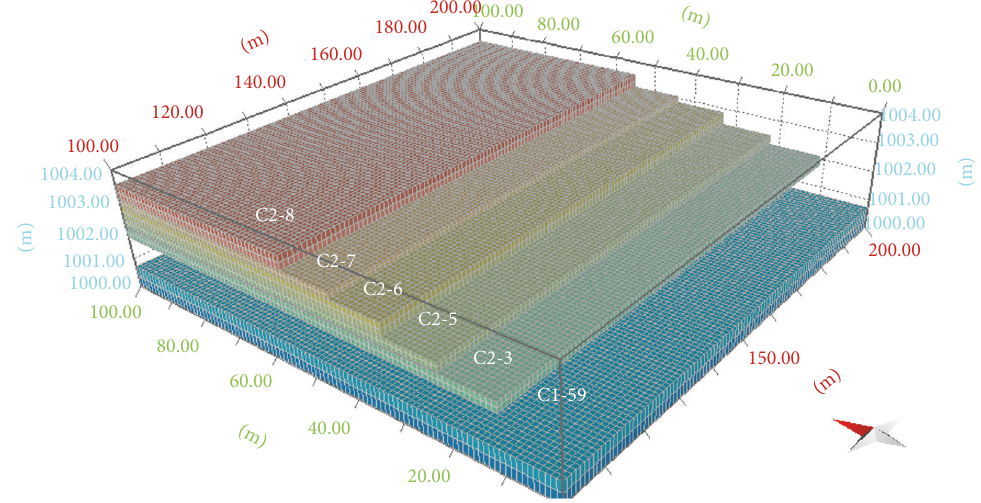
Figure 5: Basic GeoCellular Volume (10000 m 2 at the base and height proportional to the measured layer thickness) representing the six analysed beds (the model is staircase shaped to allow a clear visualization of each